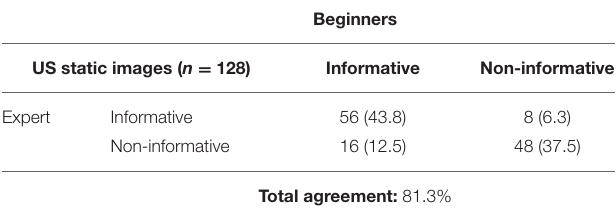
TABLE 3 | Interobserver